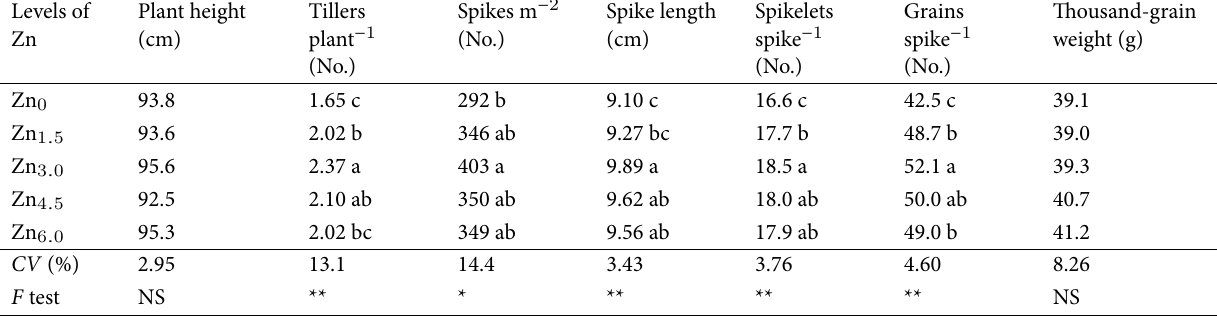
Table 2 Growth- and yield-contributing characteristics of wheat influenced by the varieties. Variety Plant height